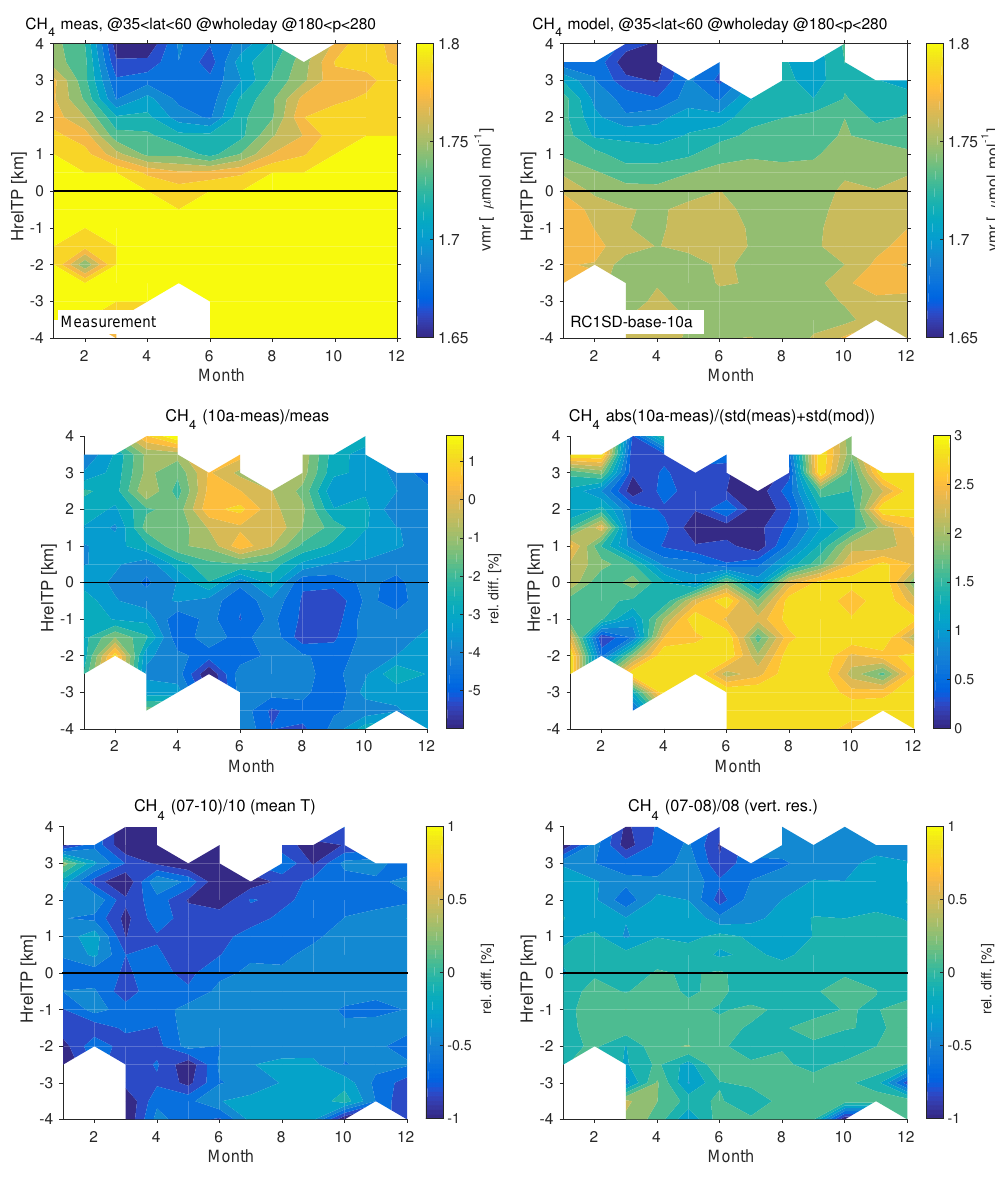
Figure 21. As Fig. 19, but for CH 4 .